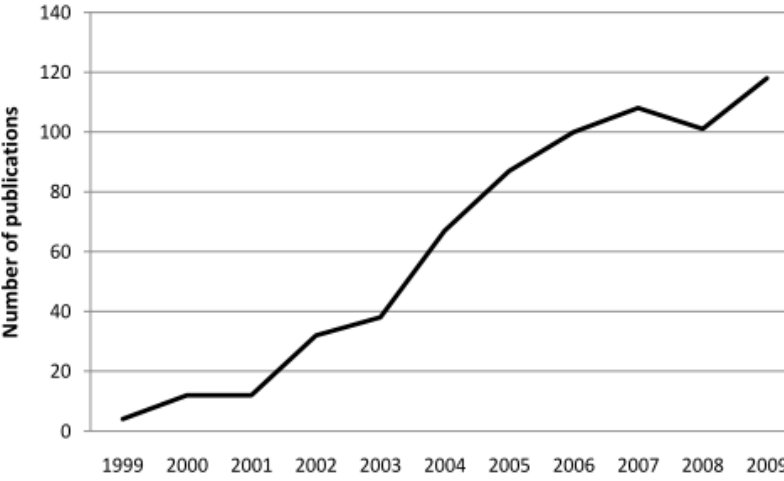
Figure 3. Number of publications on EBC over the past 10